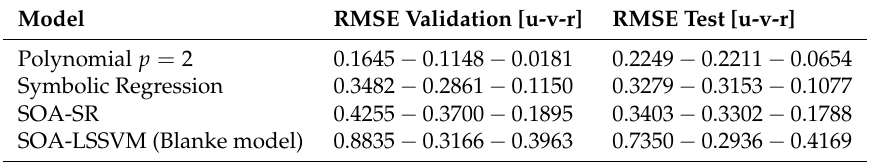
Figure 8. Test set for best models with the polynomial kernel ( a ) surge speed, ( d ) sway speed, ( g ) yaw rate; SR ( b ) surge speed, ( e ) sway speed, ( h ) yaw rate; and SOA-SR ( c ) surge speed, ( f ) sway speed, ( i ) yaw rate. Table 3. Best models Validation and